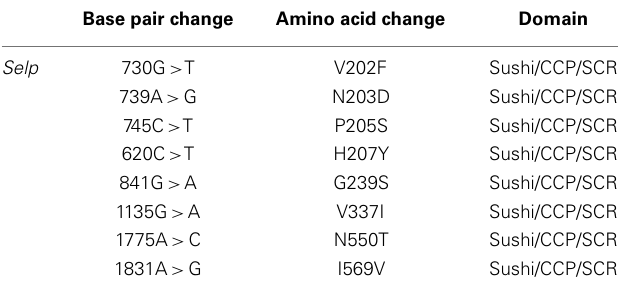
Table based on data from the Mouse Genome Informatics (MGI) website. Table 2 | Exonic variation in the MOLF/Ei allele of the Selp gene .